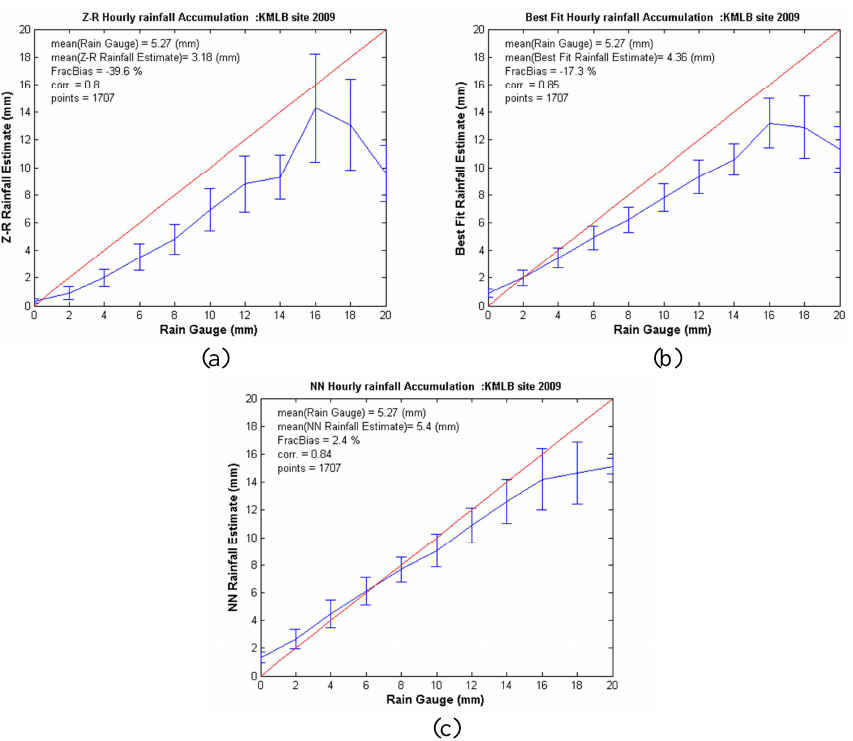
F IG . 10: Standard deviation plot of actual rain gauge vs. a) Z-R estimate b) Best Fit estimate c) NN estimate. Data from year 2009 over KMLB. (Hourly Rainfall Accumulation).